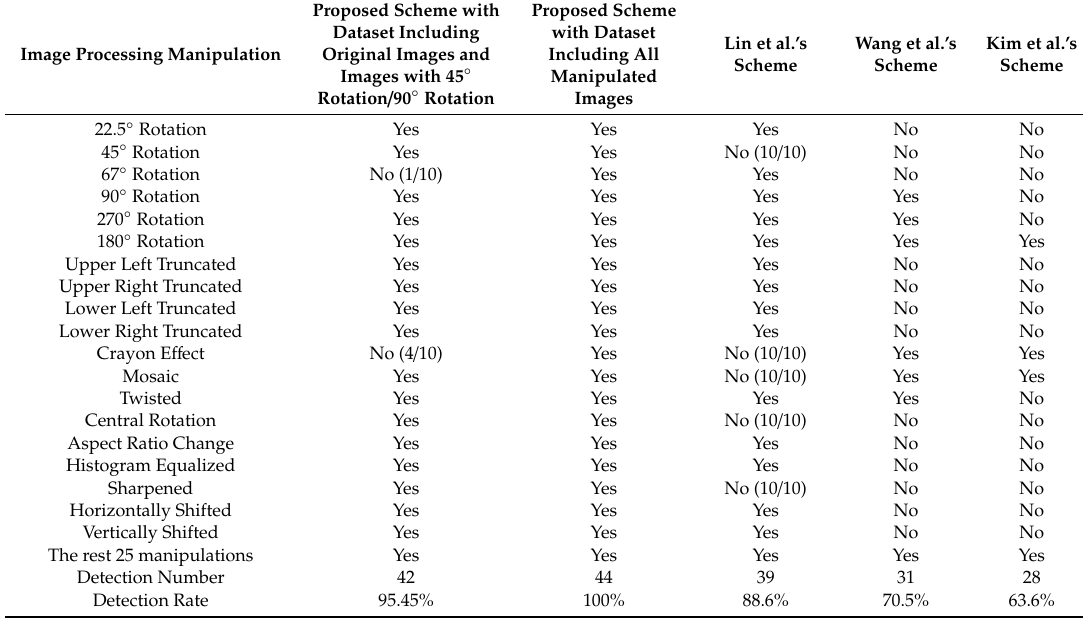
Table 6. Comparison II of the detection results in di ff erent image processing manipulations.